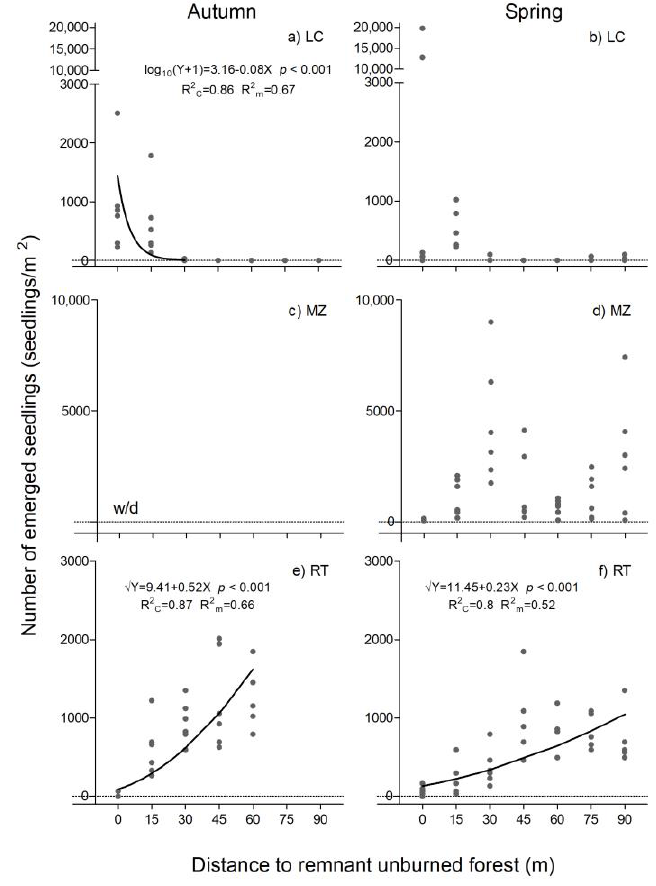
Figure 5. Emergence of herbs species in La Colisión (LC, ( a , b )), Monte Zeballos (MZ, ( c , d )) and Río Turbio (RT, ( e , f )), as a function of the distance from the edge of the remnant forest to the burned area, in autumn (left) and spring (right). Dots represent the observed emergence in each sample soil and lines indicate the simple linear regression for the evaluated range. w/d: without data.